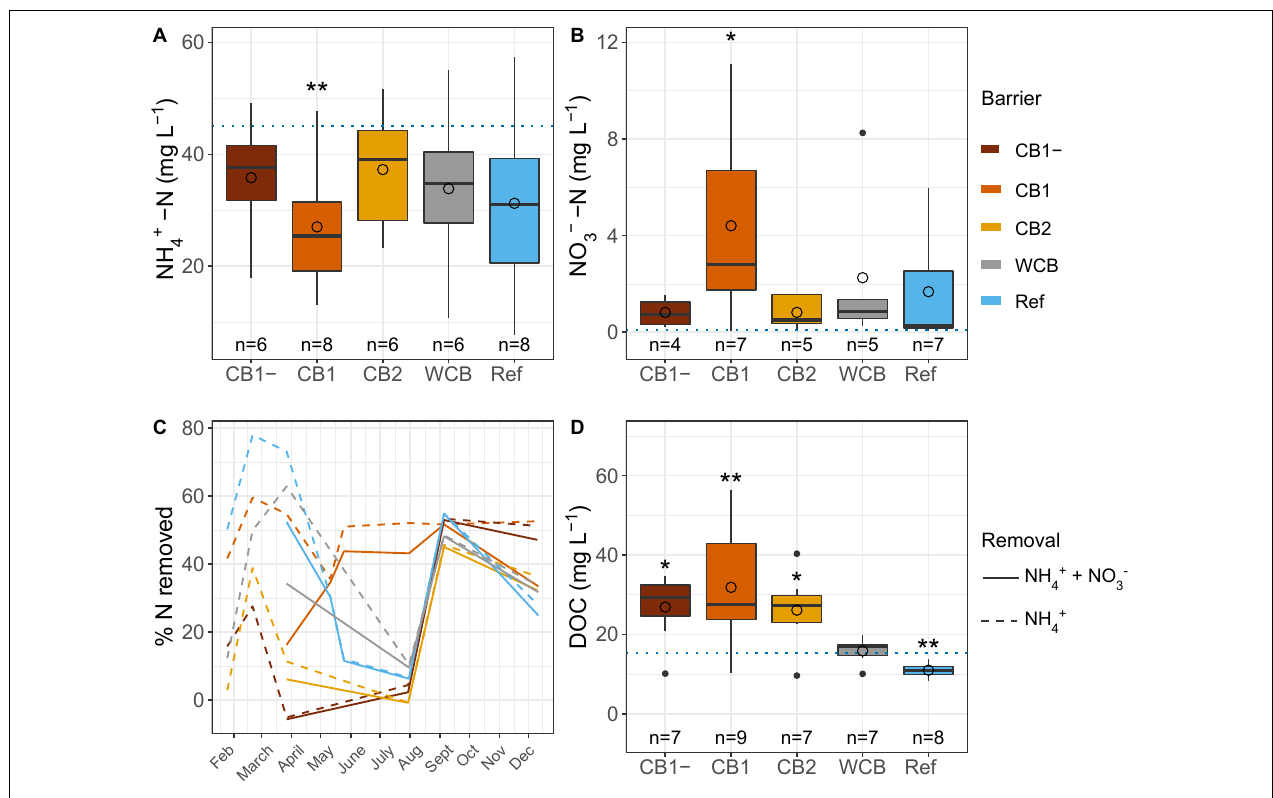
FIGURE 2 | Water chemistry after passage through the reactive barriers and reference across all time points. (A) Ammonium concentration, (B) nitrate concentration, (C) removal of total reactive nitrogen and ammonium over time, and (D) concentration of dissolved organic carbon. Inflow concentrations are indicated with dotted lines in panels (A,B,D) (mean values over the year, n = 31, 29, and 12 for ammonium, nitrate, and dissolved organic carbon, respectively). Box limits represent the inter-quartile range with median values represented by the center line and mean values by circles. Whiskers represent values ≤ 1.5 times the upper and lower quartiles, while points indicate values outside this range. The number of samples per barrier is indicated below the boxes. Stars denote if the mean value is significantly different from the mean inflow value ( t -test, * p < 0.05, ** p <